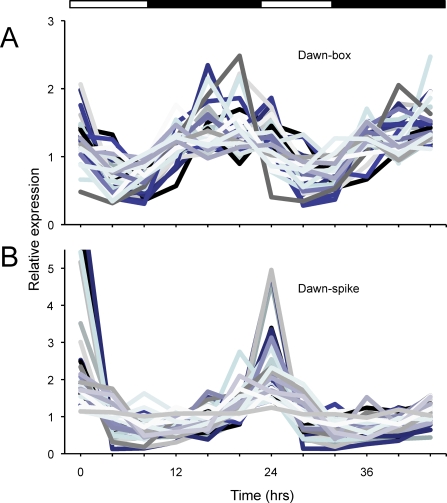
Phytohormone Genes Associated with Growth PhaseOf the 182 phytohormone genes, 71 were identified as growth associated (p < 0.01), using either dawn-box (A) or dawn-spike (B) models under short-day photocycles.(A) Thirty-one dawn-box growth-associated phytohormone genes.(B) Forty dawn-spike growth-associated phytohormone genes.